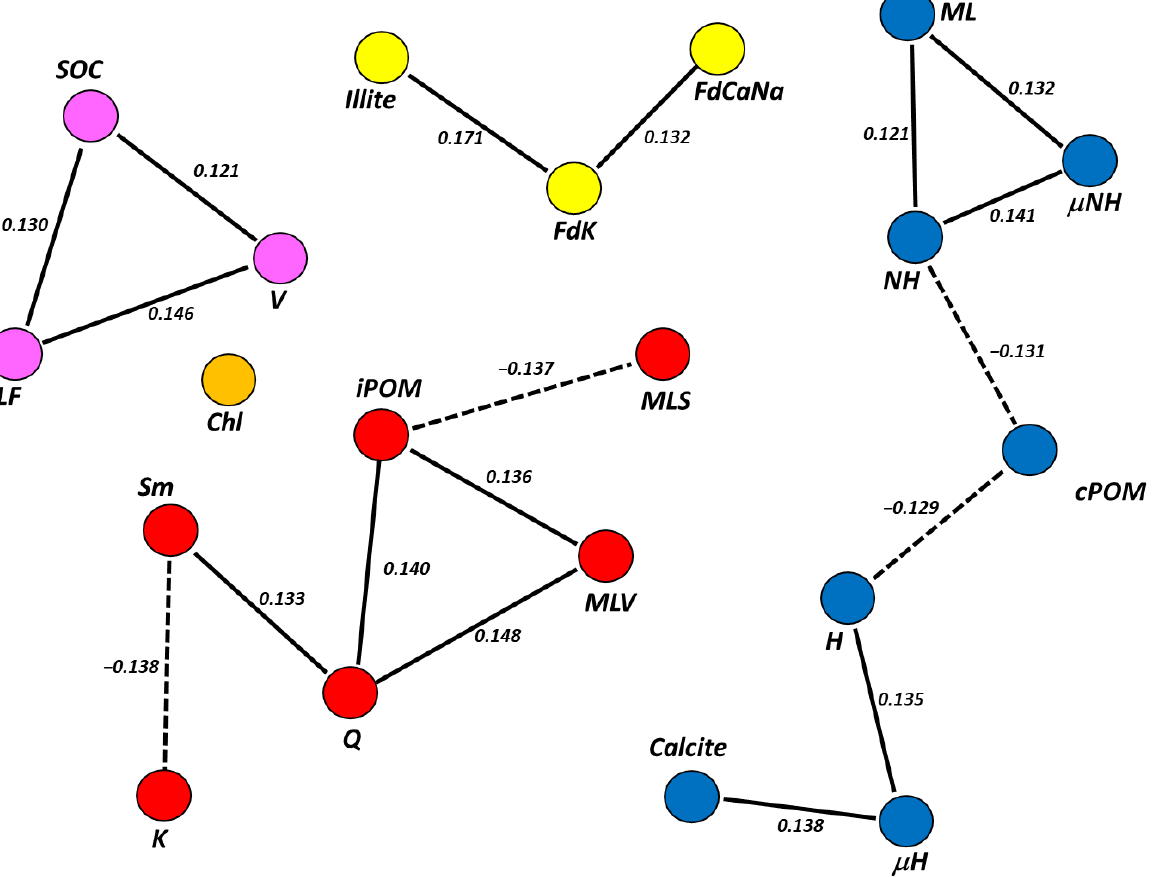
Figure 7. PCN between SOC pool subfractions and soil clay minerals at p < 0.05 and false discovery rate < 0.20. Dashed lines: negative correlations. (For abbreviations, see Tables 2–5). Colors show different clusters of variables.